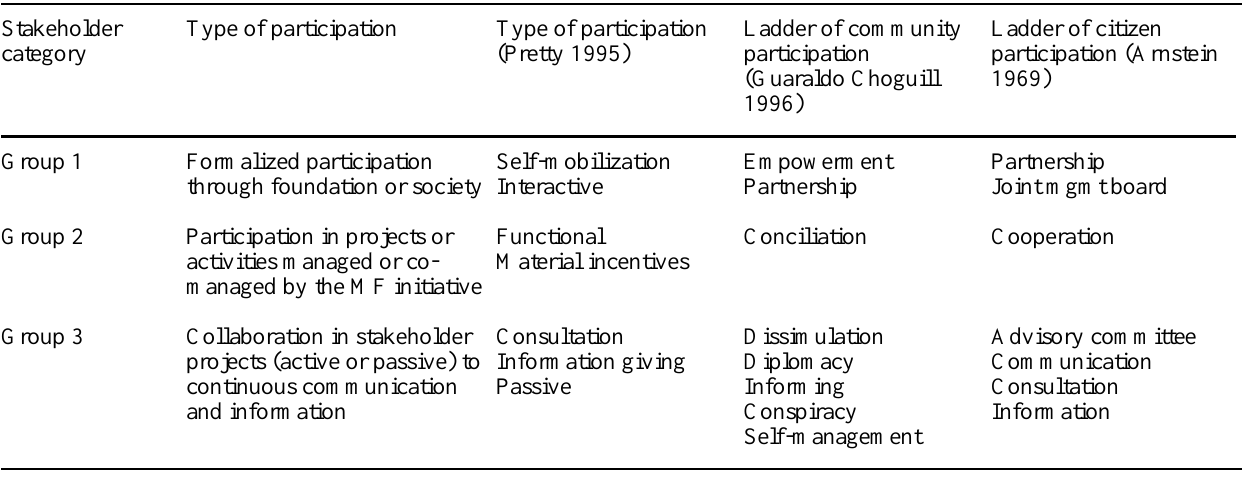
Table 1. Rule for distinguishing stakeholders involved in a MF initiative according to level of